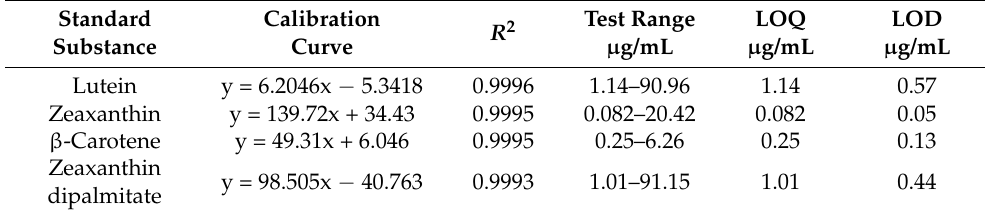
Table 3. Calibration curve, LOQ and LOD of standard substances.